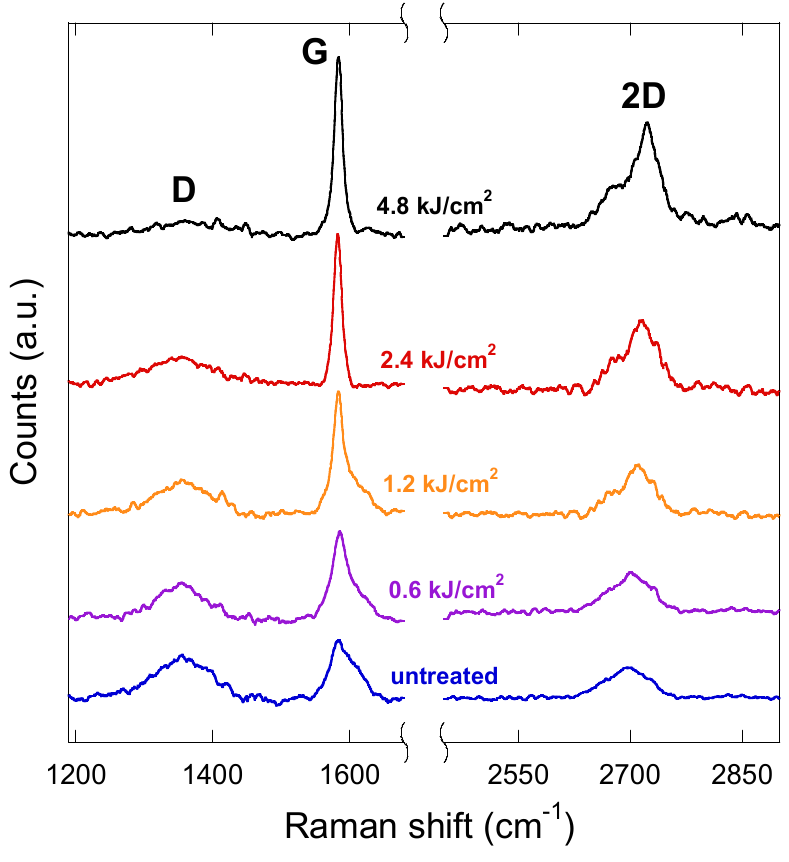
Figure 5. Raman spectra of carbon films laser-treated at different values of total accumulated laser fluence. Spectra recorded from areas treated at Φ A ≤ 0.3 kJ/cm 2 , being perfectly overlapping to each other and to the one measured for Φ A = 0 (as-annealed untreated case), are not shown. As a general comment on all the spectra, the contribution of graphite micro-particles to Raman signal prevails over the one given by carbon black nanoparticles. In carbon black, G and D bands overlap [26,27], and the 2D band spreads over a Raman shift range of about 1000 cm in our case, G and D bands are well-separated (Figure 5), and the 2D band is always narrower − 1 than 200 cm , as is commonly observed in graphite-based systems regardless of their structural quality